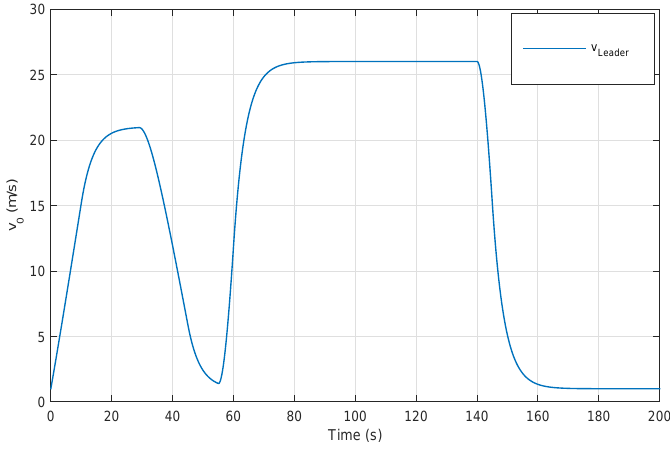
Figure 5. Leader vehicle speed